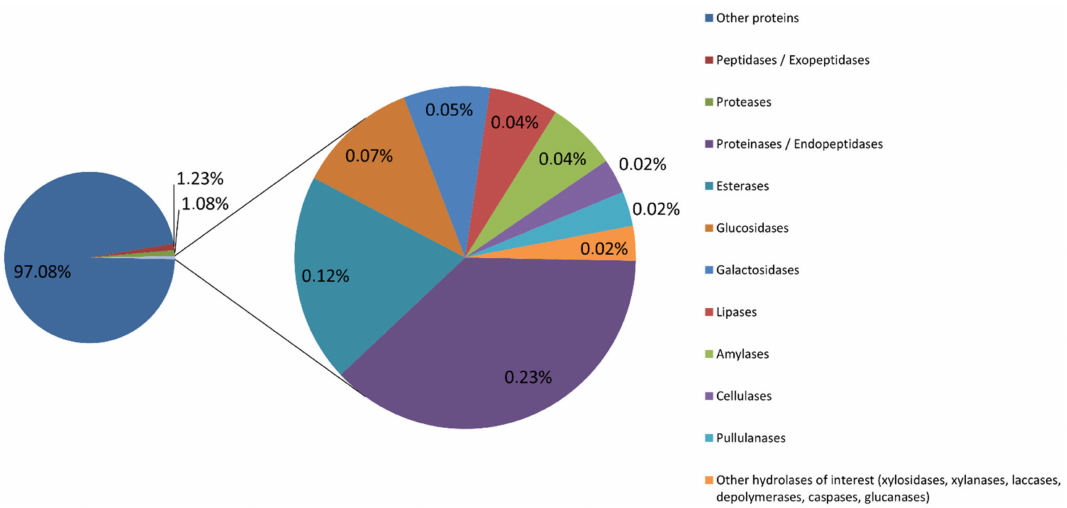
Figure 2. Relative abundances of hydrolases from the metagenomic sample obtained in Muiño da Veiga. Abundance was measured as number of counts obtained by the DIAMOND aligner using the NCBI NR database. The total amount of counts was 43,613,726. Of those, 1,276,574 counts (2.93%) were annotated as hydrolases with possible interest in industrial processes: proteases and peptidases (exopeptidases, endopeptidases and proteinases), esterases and lipases, amylases, cellulases, glucosi- dases, galactosidases, pullulanases, xylosidases, xylanases, laccases, depolymerases, caspases and glucanases. Relative abundances of each enzyme class are given as a percentage of the total number of counts